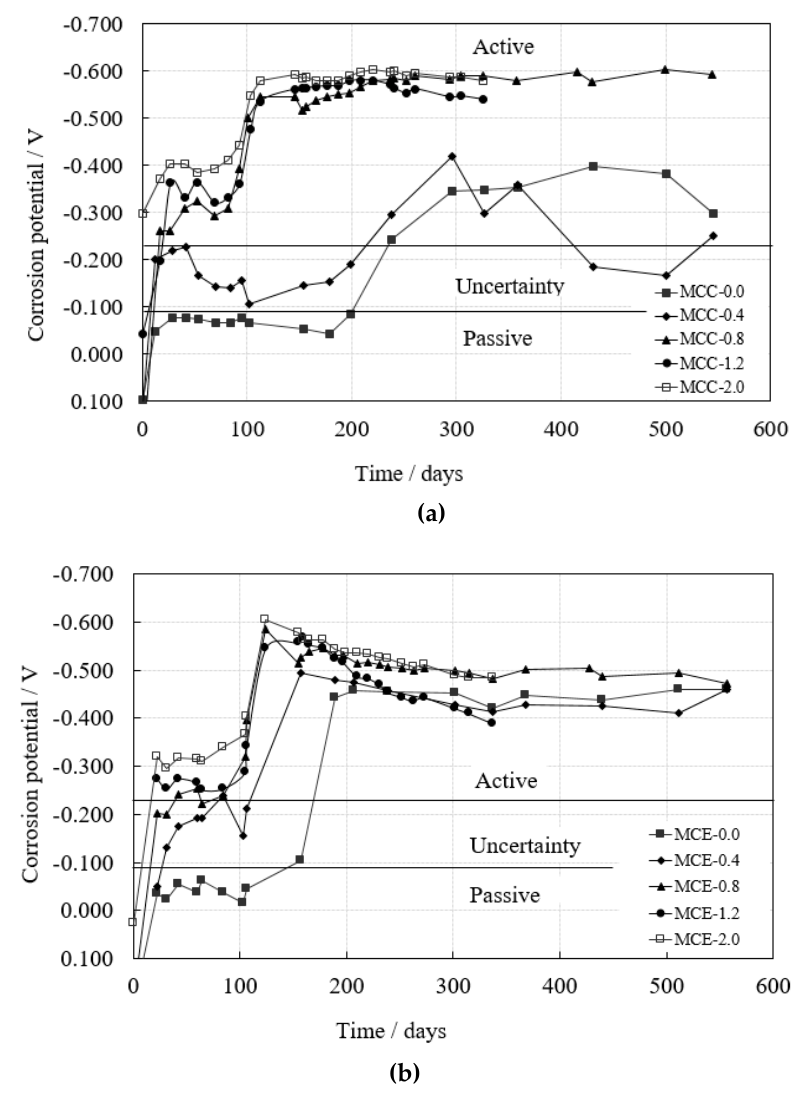
Figure 3. Evolution of E corr over time in standard test specimens ( a ) and in LFS specimens ( b ) at different chloride ion percentages.